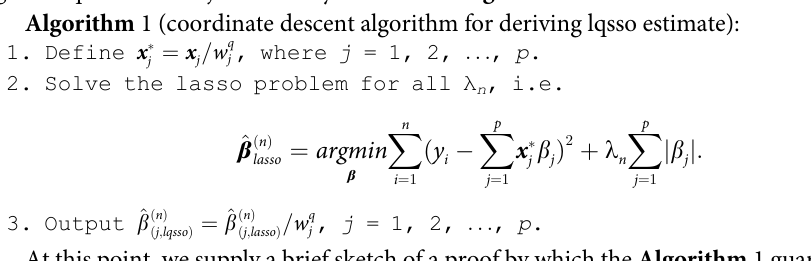
Algorithm 1 (coordinate descent algorithm for deriving lqsso